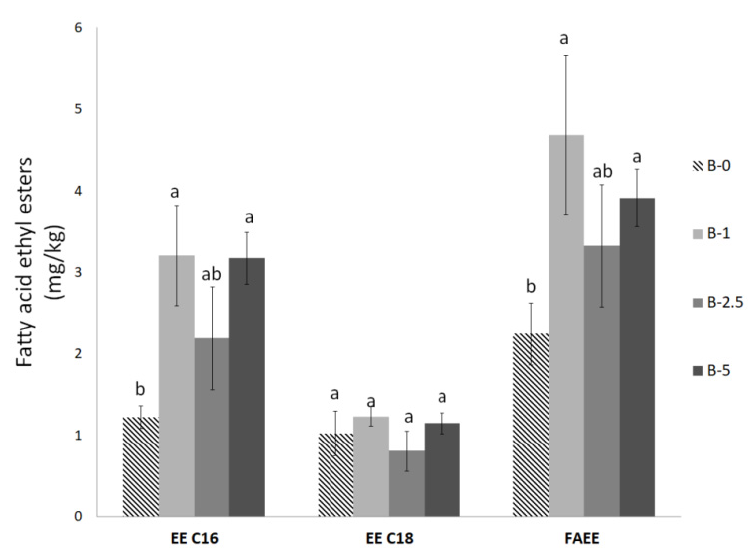
Figure 2. Concentration (mg/kg) of fatty acid ethyl esters (FAEE) in Buža olive cultivar oil obtained without (B-0) and with the addition of different amounts of olive leaf: 1% (B-1), 2.5% (B-2.5) and 5% (B-5). Results represent mean values of three technical repetitions ± standard deviations. Different letters above bars represent significant differences among the treatments (Tukey’s test, p < 0.05) for each parameter separately. FAEE represents the sum of ethyl palmitate (EE C16) and ethyl stearate (EE